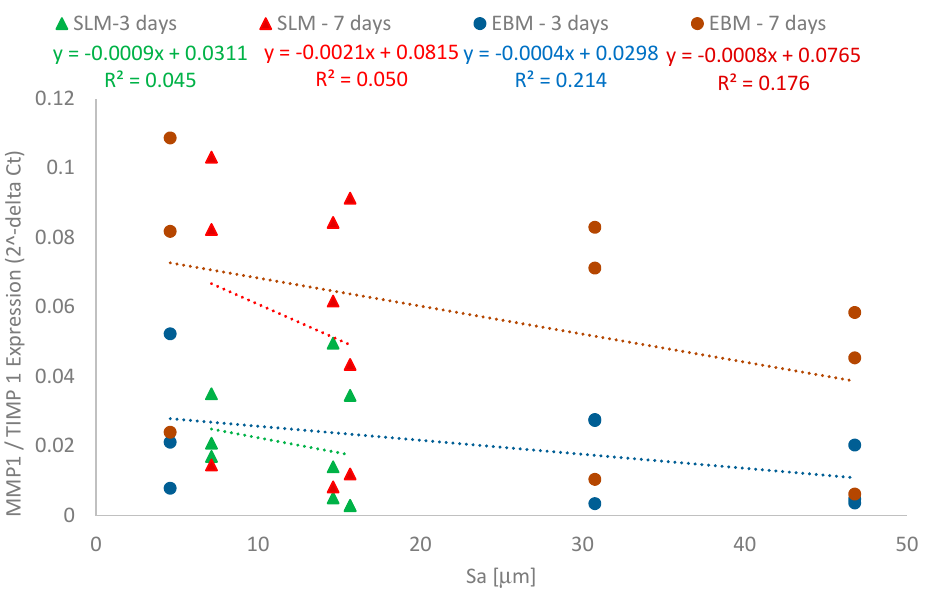
Figure 7. Correlation between the surface roughness (Sa) and the bone degradation factors, MMP 1 and TIMP 1 .